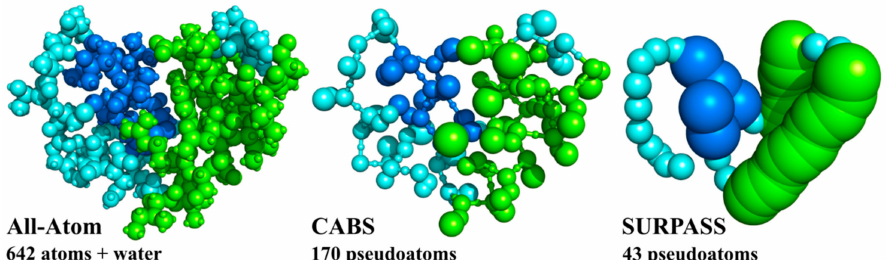
Figure 3. All-atom (AA) and two coarse-grained (CG) representations of protein structures. For a small protein (PDB code: 1CRN), consisting of 46 residues, AA representation needs the explicit treatment of 642 atoms (and a large number of solvent atoms when an explicit solvent model is analyzed). A lower-resolution CG CABS model (CA, CB, Side chain model) requires explicit treatment of 170 pseudoatoms and the deeply CG Single United Residue per Preaveraged Secondary Structure fragment (SURPASS) model reduces the number of simulated pseudoatoms (or rather pseudoresidues in this case) to just 43, reducing simulation cost by orders of magnitude (Figure 2). In both cases of